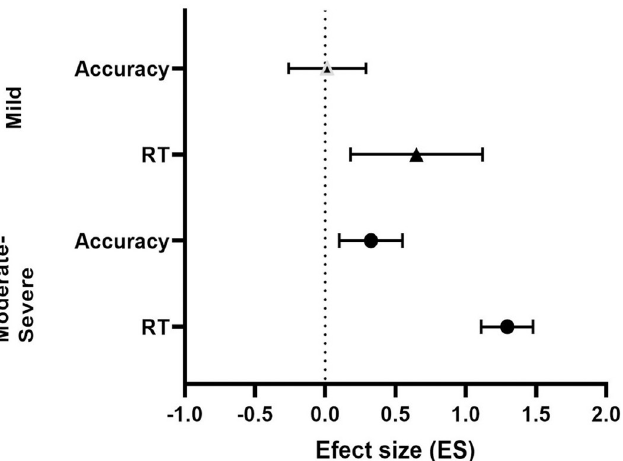
Fig 4. A forest plot showing subgroup analysis based on TBI severity (mild and moderate-severe) for accuracy and reaction combined effect-sizes.